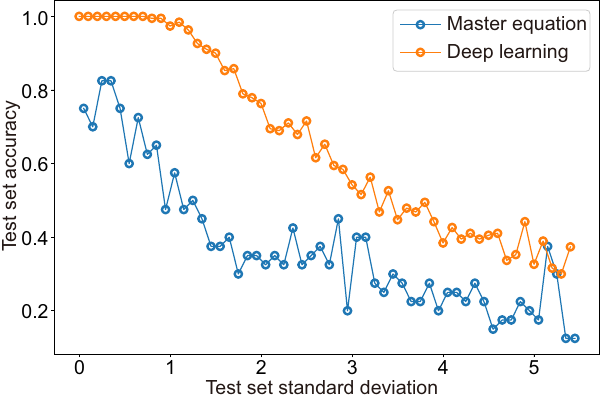
Fig. 4 Prediction accuracy of deep learning model and the master equation on the noisy test set. The noise is white noise with mean μ = 0 and a standard deviation σ . The noise is added quantitatively using different σ values. Before and after addition of the noise, the data are scaled between 0 and 1 using their maximum and minimum. The deep learning model is trained in a training set without additional noise. In addition, we do not involve noise spectrum when solving the master equation. Each point is obtained after averaging of fi ve predictions on the noisy